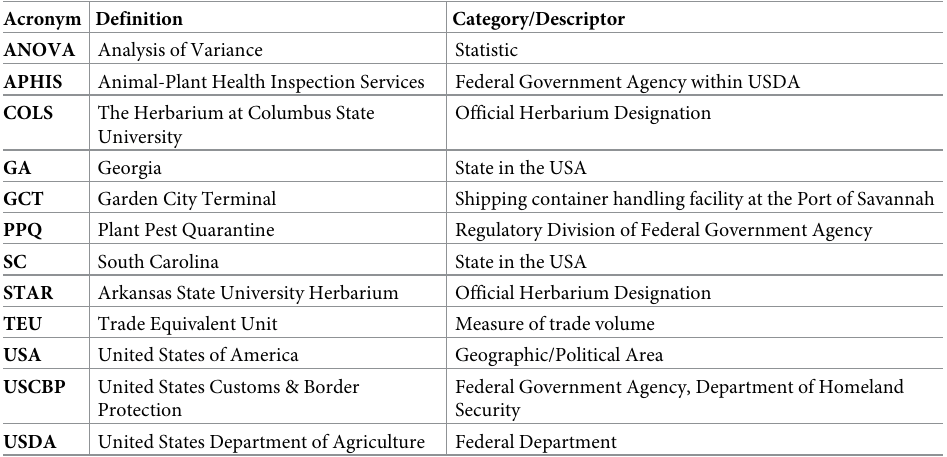
Table 1. Reference table of acronyms used throughout this